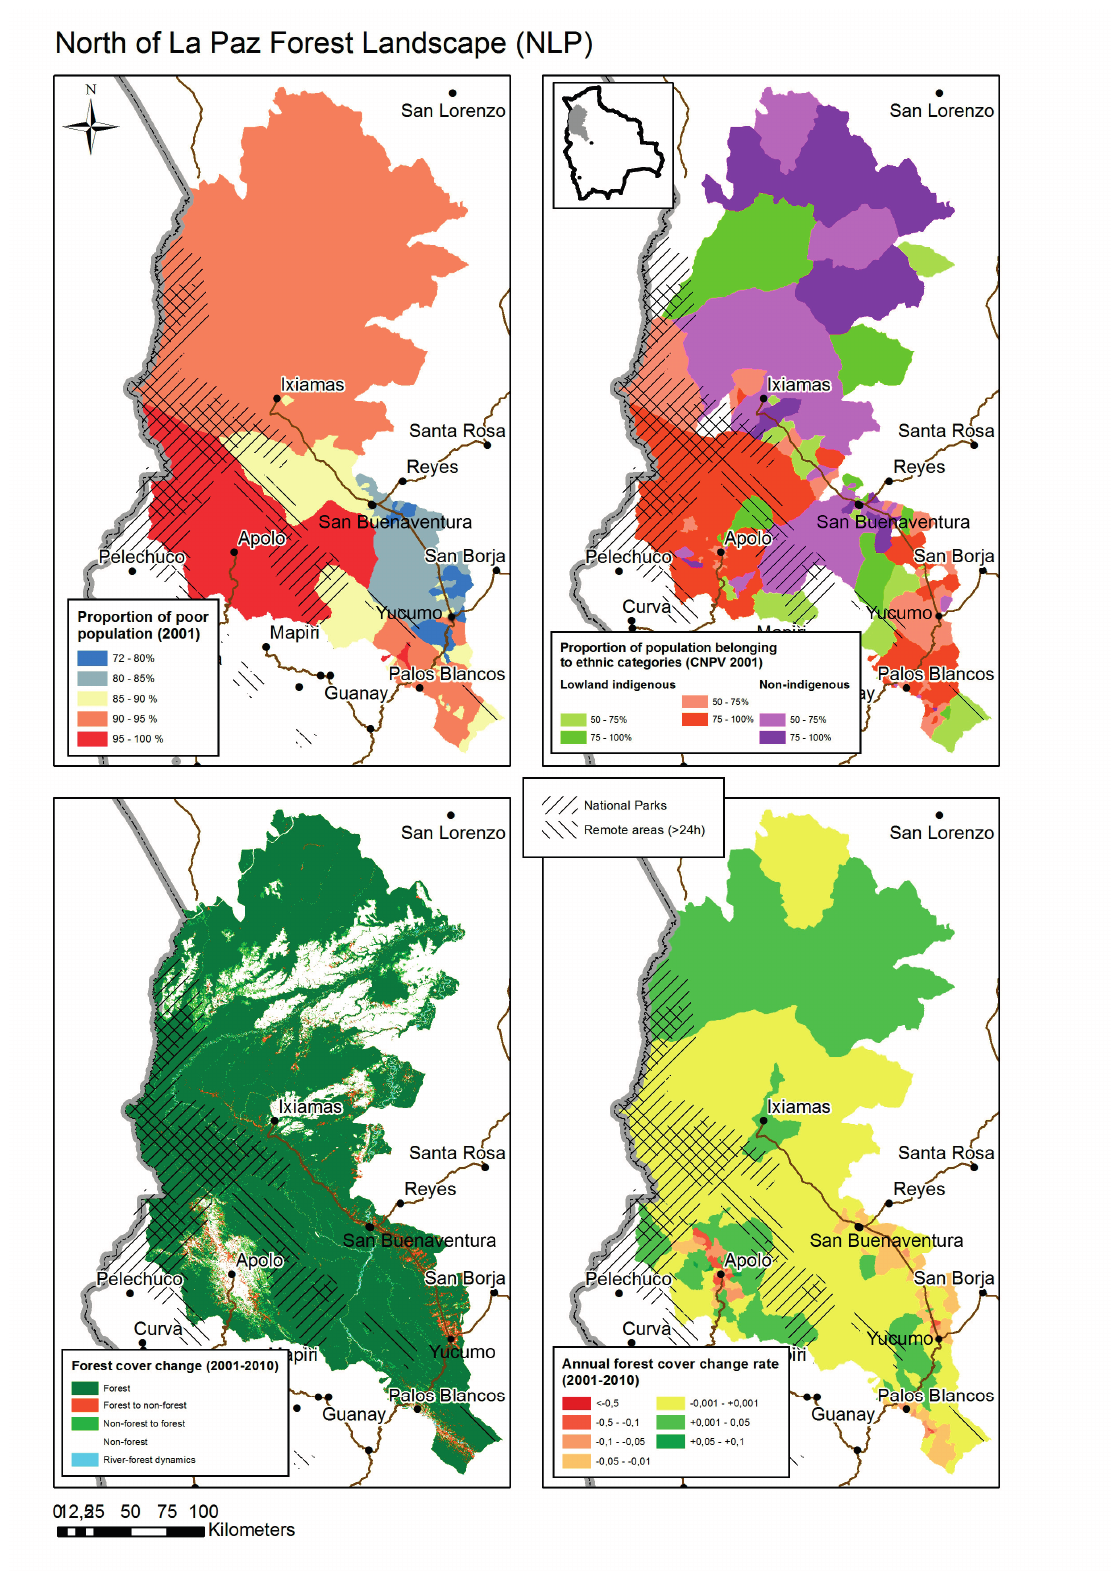
Figure 3. Poverty, ethnic groups and forest cover change in the North of La Paz forest